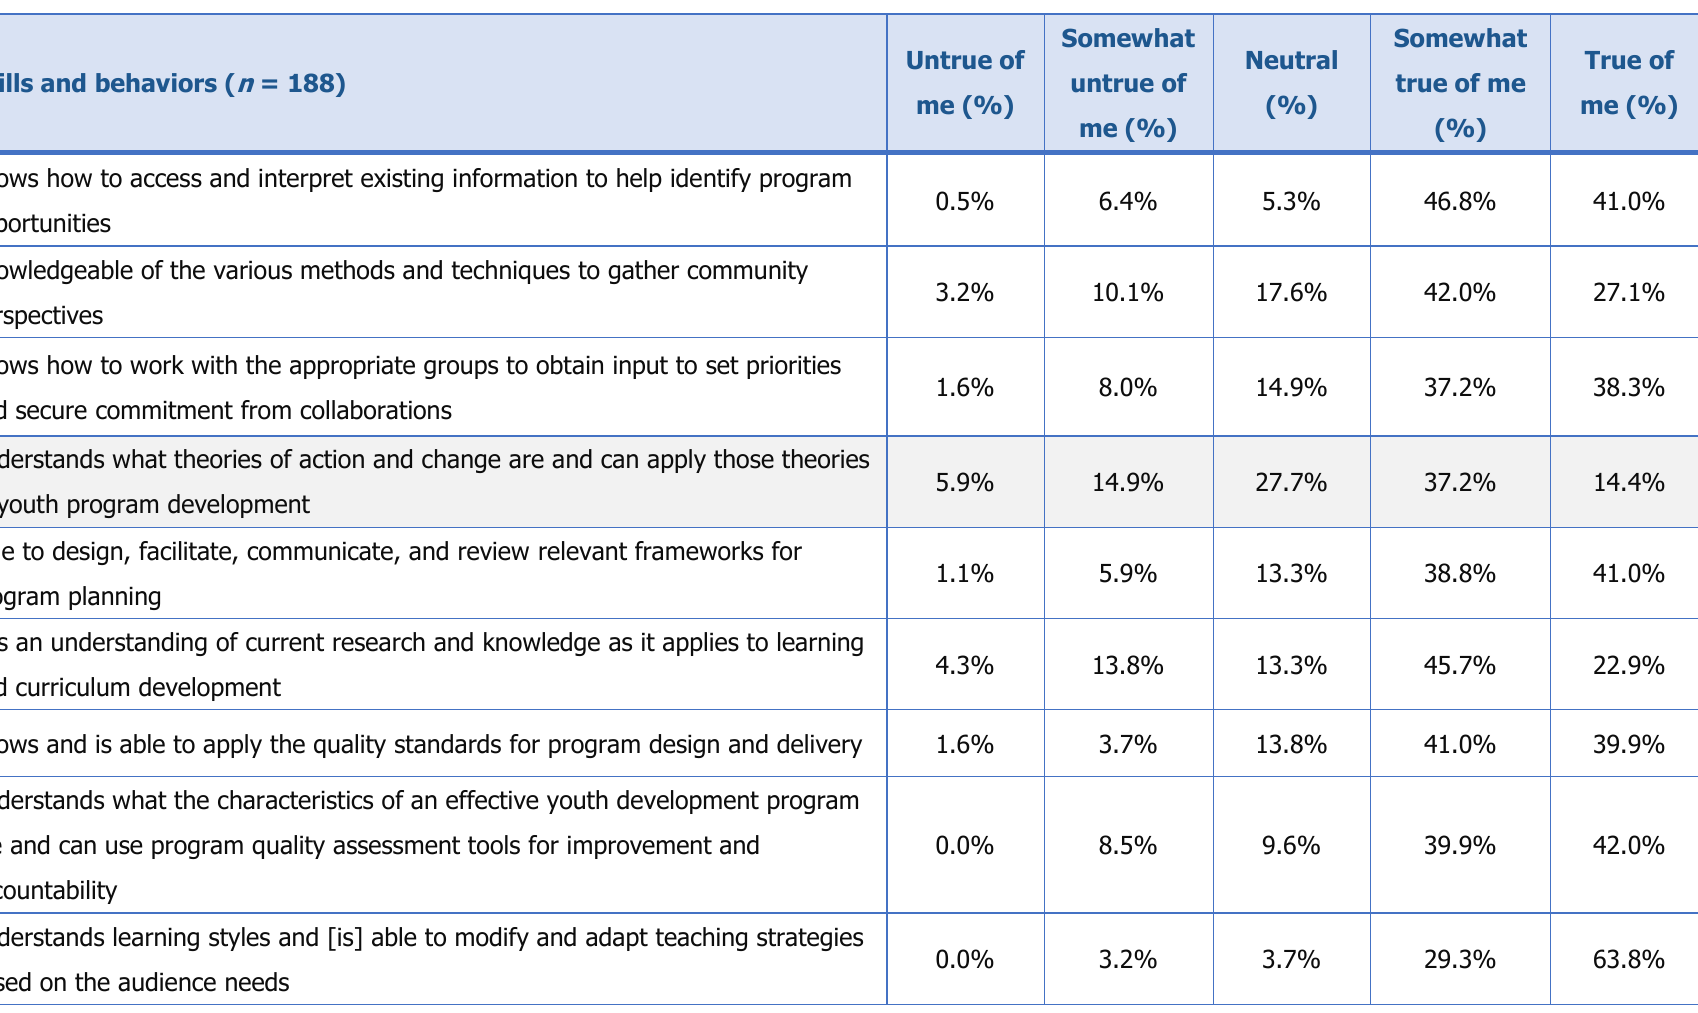
Table 4. Youth Program Development Competencies (Planning, Implementing, and Evaluating Programs That Achieve Youth Development Outcomes)